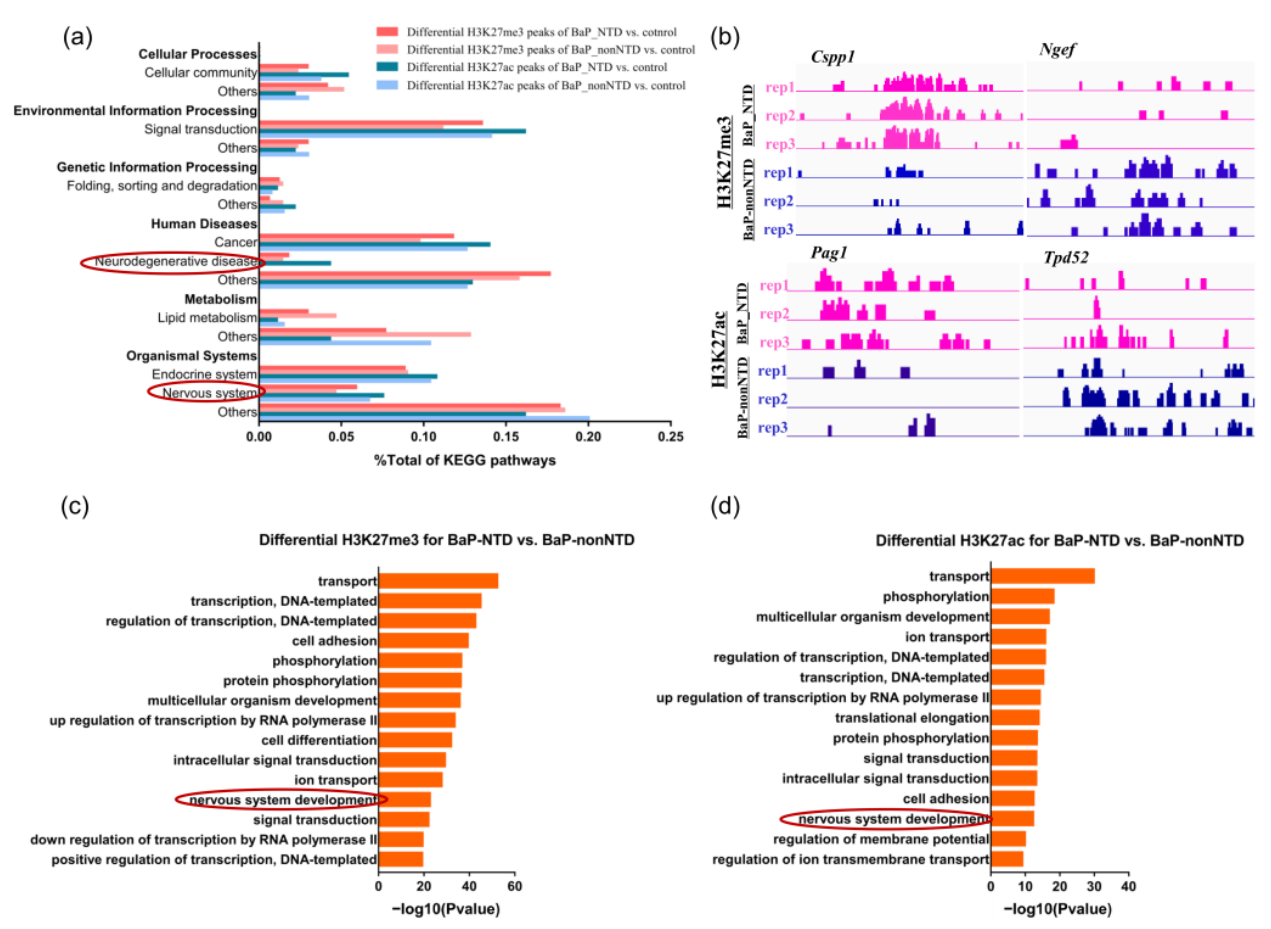
Figure 3. Analysis of differentially modified histone peaks in E9.5 mouse embryos with and with- out NTDs. ( a ) Overview of KEGG enrichment analysis of differentially modified histone peak binding genes identified in BaP-NTD-vs-control and BaP-nonNTD-vs-control comparisons. ( b ) In- tegrative genomics viewer snapshot of representative differential modified H3K27me3 and H3K27ac signals in comparison of BaP-NTD with BaP-nonNTD. Biological process GO enrichment terms for the differential H3K27me3 ( c ) and H3K27ac ( d ) peak binding genes identified in BaP-NTD-vs-BaP-nonNTD comparisons, ordered by adjusted p -value. Neurodevelopment associ- ated terms were marked with red circles.